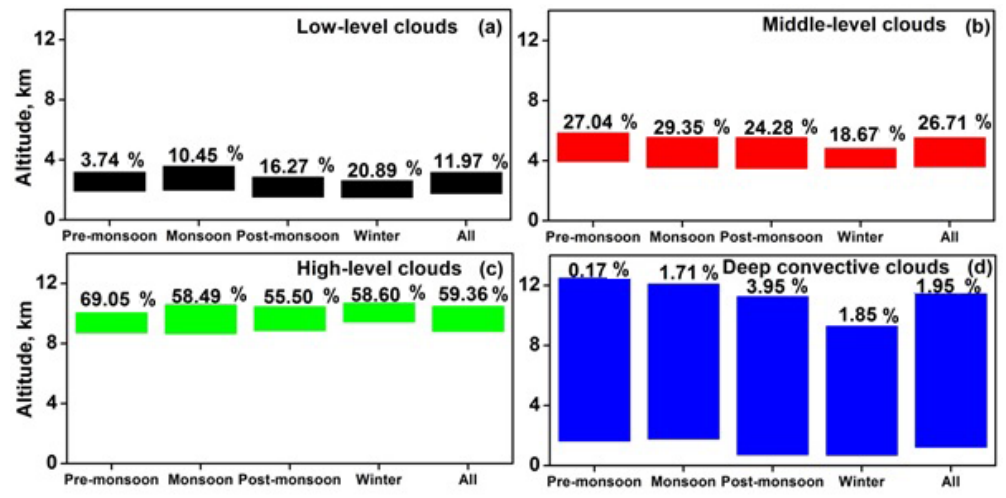
Figure 9. Mean vertical locations (base and top), cloud thicknesses, and percentage of occurrence of (a) low-level clouds, (b) middle-level clouds, (c) high-level clouds, and (d) deep convective clouds observed during different